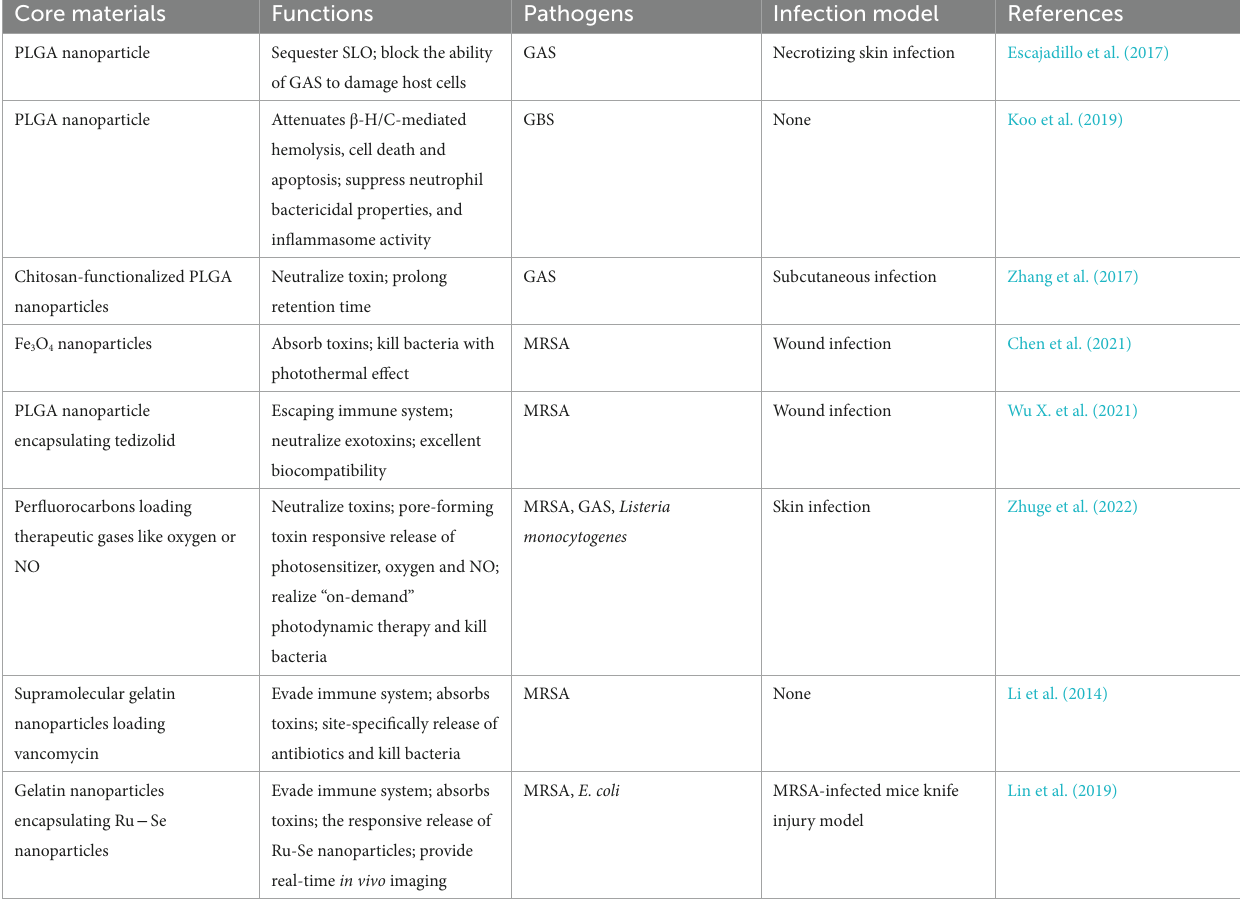
TABLE 1 Representative red blood cell (RBC) membrane coated nanoparticles for therapy of bacterial infection.